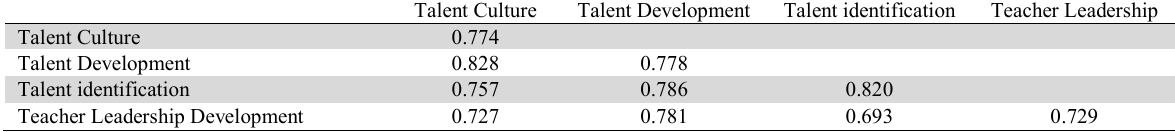
Discriminant Validity (n-473)